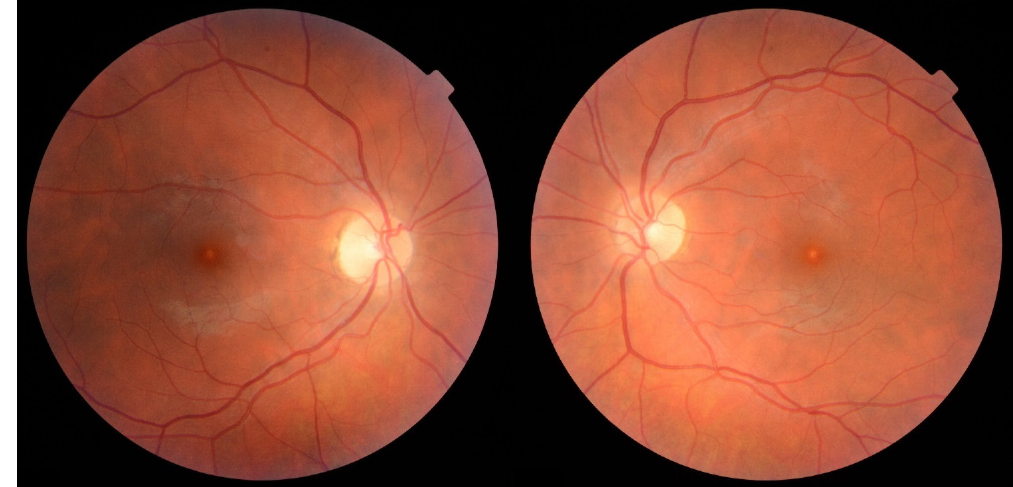
Figure 1: Color fundus image of both eyes that show white discolorations in the fovea